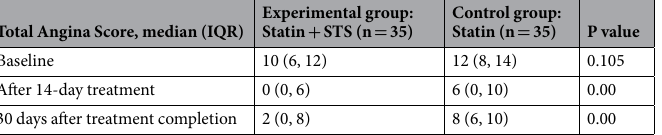
Table 4. Comparison of angina score between groups at baseline and after treatment. IQR, interquartile range; STS, sodium tanshinone IIA sulfate. Inter-group comparison was analyzed using the Wilcoxon rank-sum test, due to non-normal distribution of the